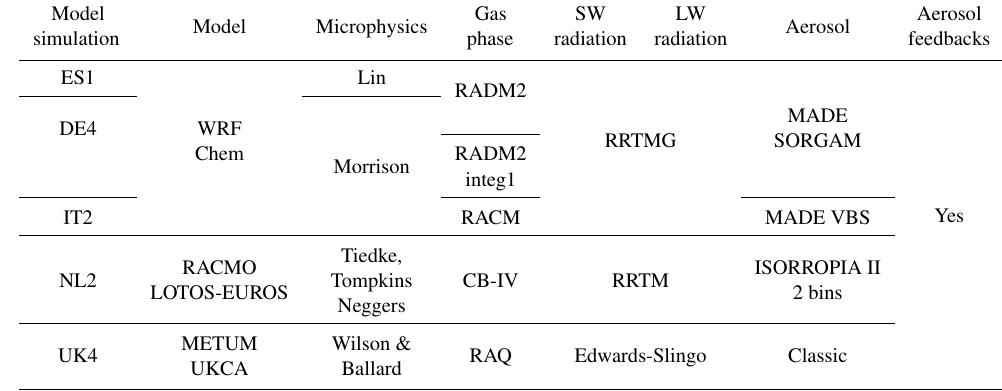
Table 1. Some of the AQMEII2 models features of the studied simulations.